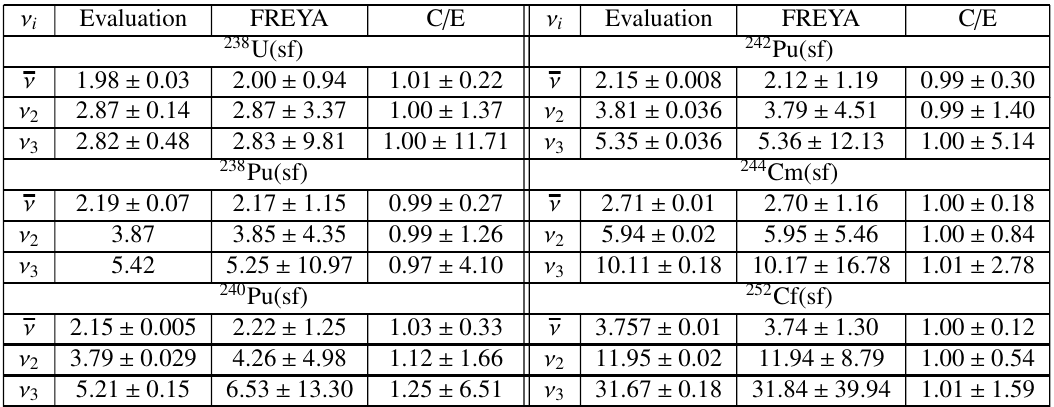
Table 2. The values of the neutron multiplicity moments, ν 1 = ν , ν 2 and ν 3 from the evaluation in Ref. [10], calculated by FREYA , and the ratio C / E (calculation to evaluation). Note that the FREYA uncertainties are not statistical but represent the uncertainties on the parameters. The FREYA uncertainties increase for the higher moments because the neutron multiplicity is multiplied for ν 2 and ν 3 . From Ref. [5].